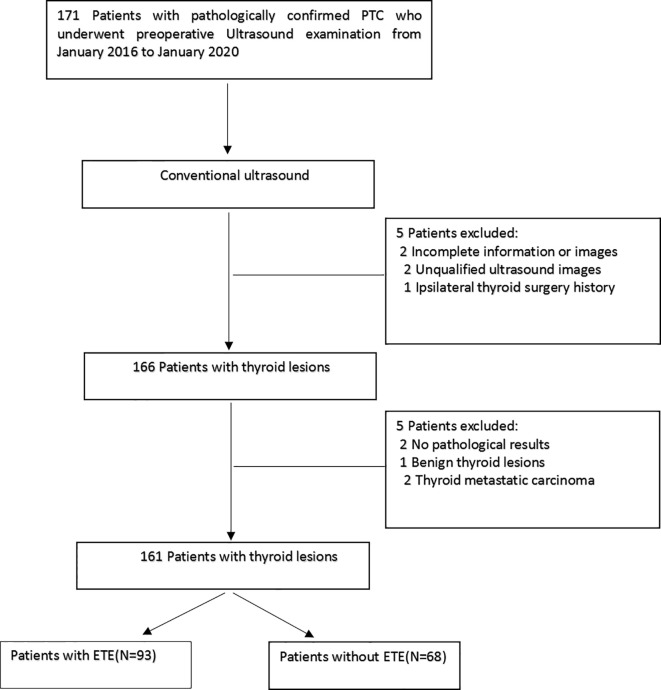
Schematic diagram of the patient selection. PTC, papillary thyroid carcinoma.